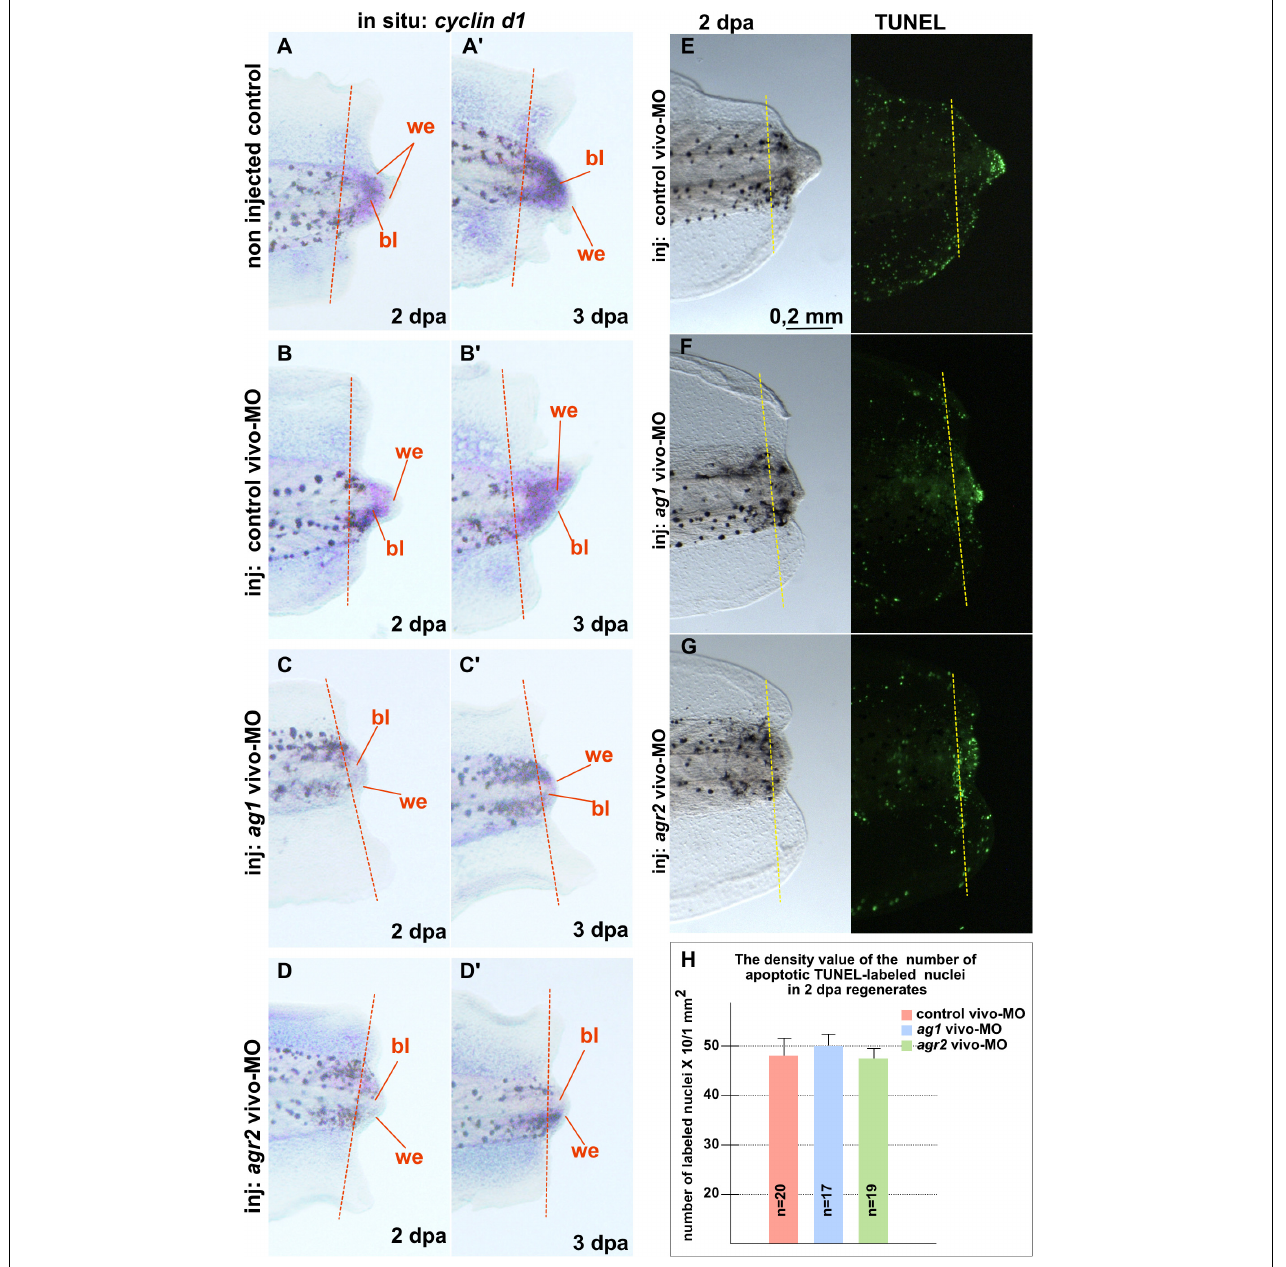
FIGURE 3 | Downregulation of ag1 and agr2 during regeneration is accompanied by cell cycle regulator cyclin d1 expression blockage but does not affect apoptosis activity in the regenerating tail. (A,A’) . Results of in situ hybridization of non-injected control regenerating tails as well as tails injected with control vivo-MO (B,B’) demonstrate active expression of cyclin D1 at 2 and 3 dpa predominantly in blastema cells. Knock-down of ag1 (C,C’) as well as agr2 (D,D’) by specific vivo-MOs result in a high reduction of cyclin d1 expression at 2 and 3 dpa. Bl—blastema, we—wound epithelium. Dashed red line indicates amputation level. Lateral view, distal to the right. (E–G) TUNEL analysis of apoptotic cells pattern in 2 dpa regenerating tails injected with control vivo-MO (E) , ag1 vivo-MO (F) or agr2 vivo-MO (G) . (H) Statistical analysis of number of TUNEL-labeled nuclei per 1 mm 2 of regenerating region, distal to the amputation level (yellow dashed line). N—number of tails